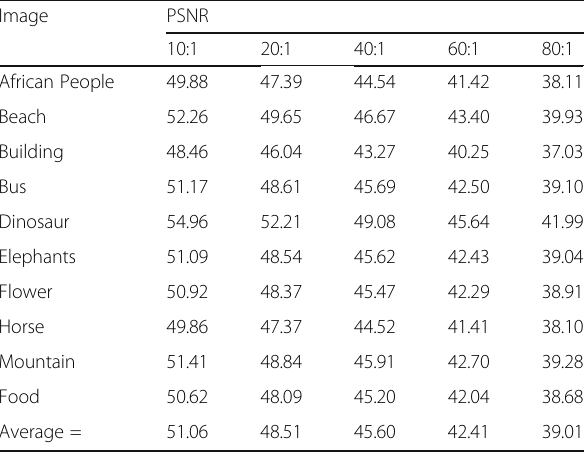
Table. 2 CR and PSNR values obtained for DB2 (codebook size = 256)